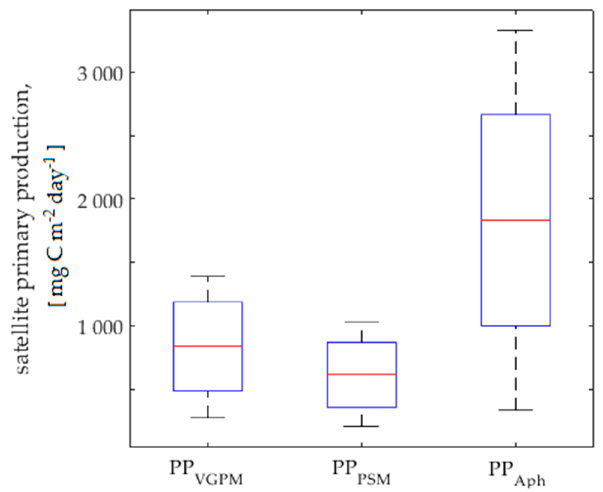
Figure 9. Box-and-whisker diagram from the sensitivity analysis for PP VGPM , PP PSM , and PP Aph in the ARCT province. Chl a and a ph (443) were changed in the models based on the variability in values at the stations.